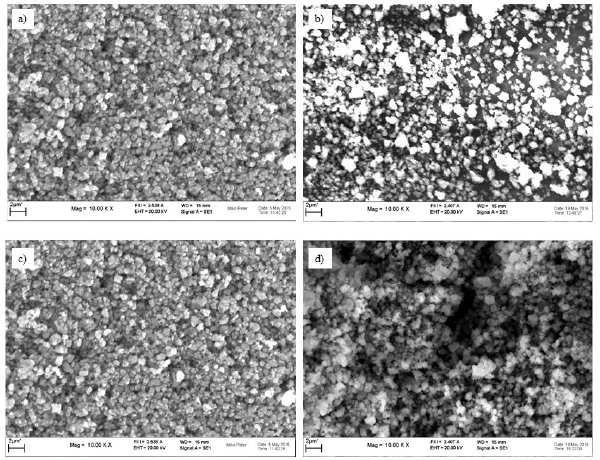
Figure 5: SEM microstructure of the TiO 2 nanopar- ticles at the beginning of the analysis for ( a ) 40 µm , and ( c ) 44 µm size, and following the extraction from the physiological solution after 14 days, for ( b ) 40 µm , and ( d ) 44 µm size.